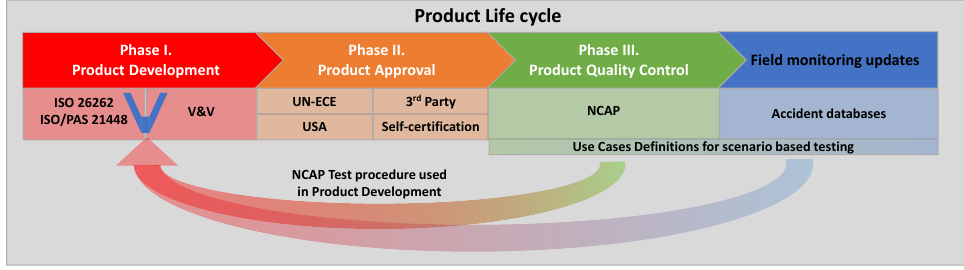
Figure 1. Automotive product life cycle phases related to V&V of